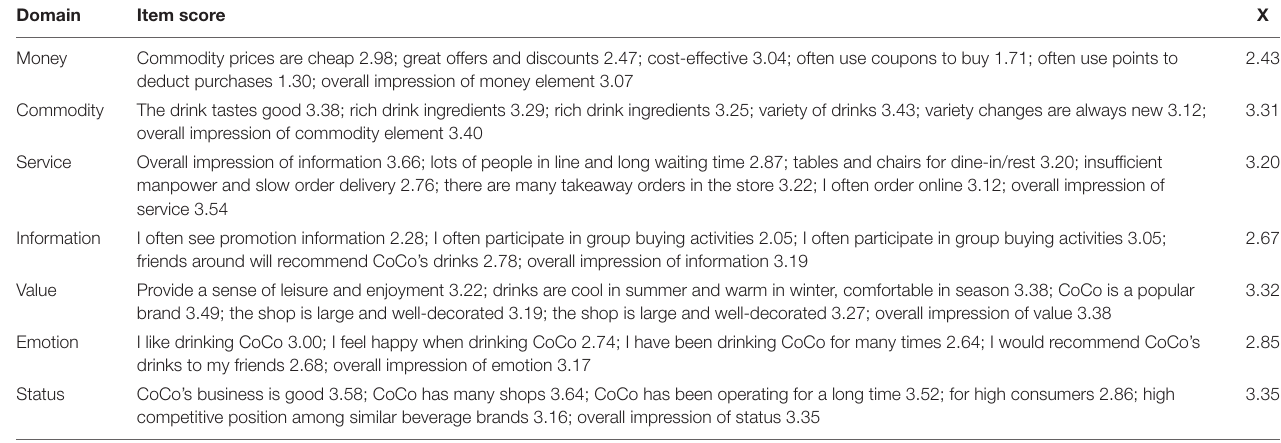
TABLE 2 | Scoring scale statistics table.